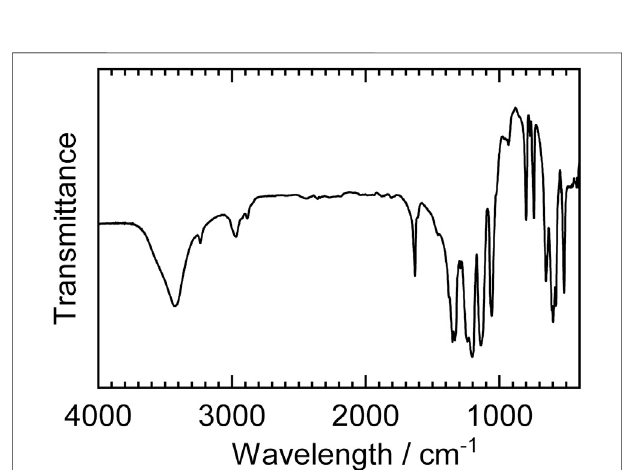
FIGURE 1 | Differential scanning calorimetry (DSC) curves of Mg(TFSA) 2 (CPME) 2 under N 2 fl ow.